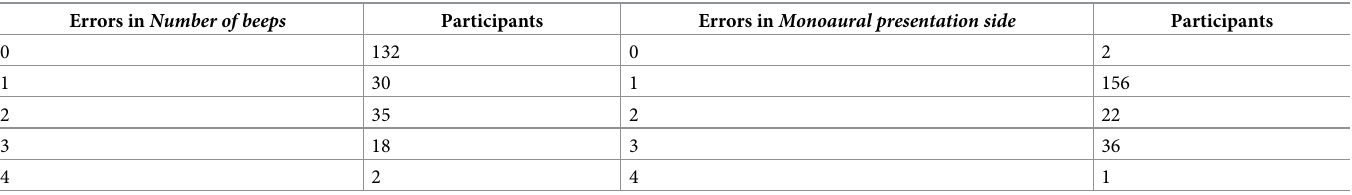
Table 1. Distribution of errors in the compliance control task 1